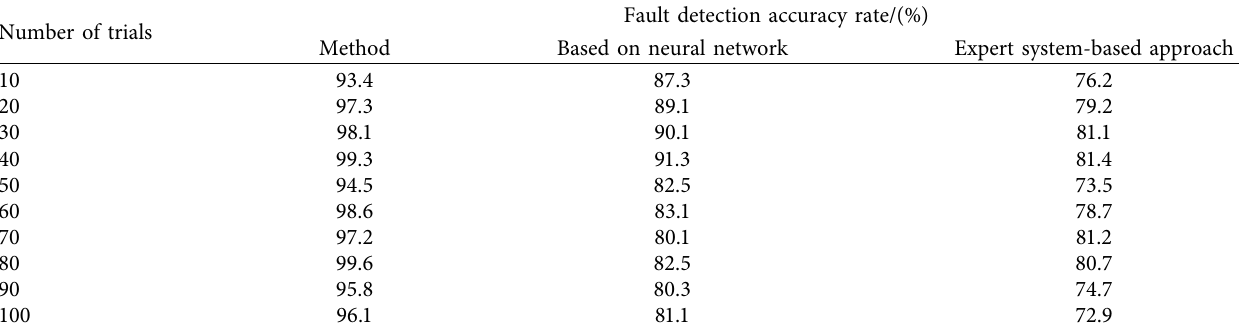
Table 1: Comparison of fault detection accuracy.